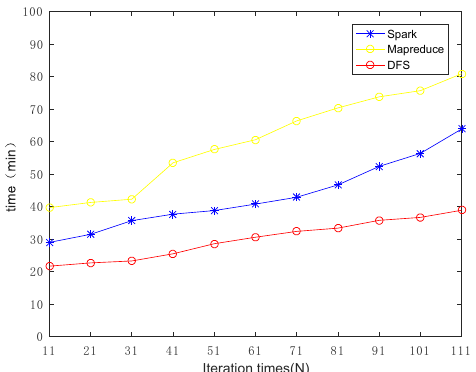
Figure 12. The effect of iteration times on the overall computing efficiency. It can be seen that, with the increase in the number of iterations, the time consumption of DFS was less than the main stream